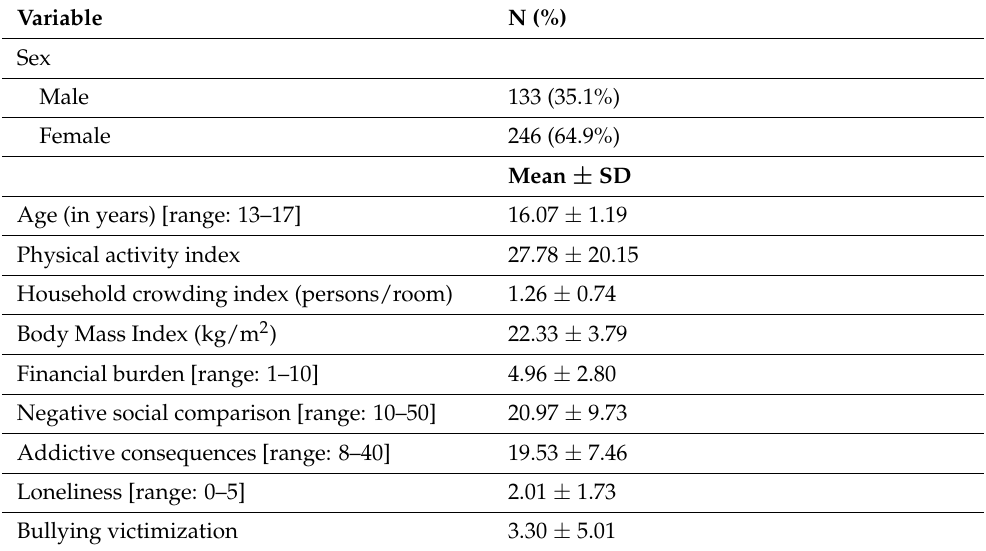
Table 1. Sociodemographic and other characteristics of the participants (N =